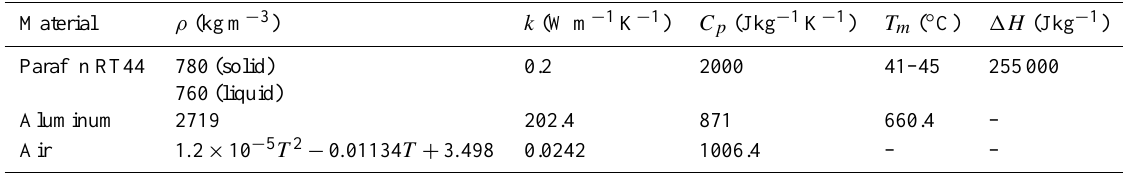
Table 2. Properties of materials employed in the present study.